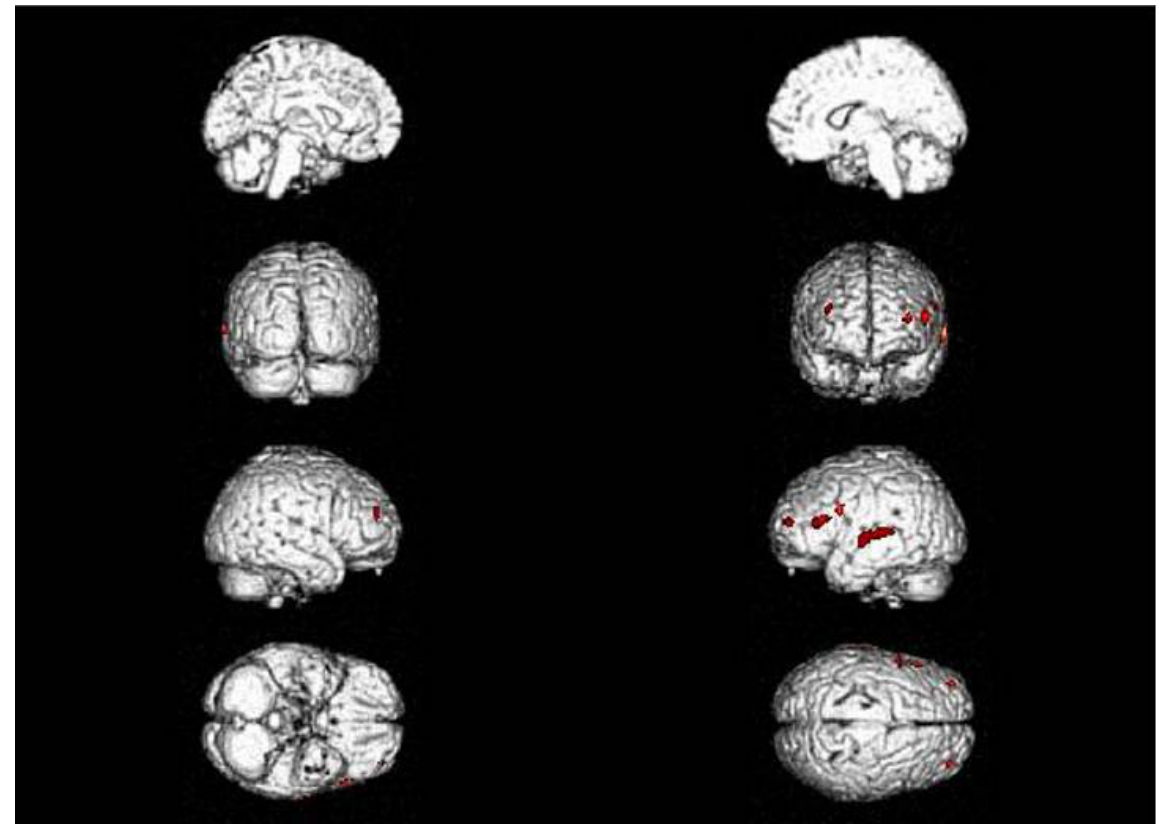
Figure 2. Brain PET with 18F-FDG one year (2013) after symptom onset (early FDG-PET). SPM map of significant hypometabolic areas ( p = 0.0001) in the left inferior frontal gyrus (BA 45), in the prefrontal cortex (BA 9 and BA 10 in the left hemisphere, BA 10 in the right one), and in the left superior temporal gyrus. The results are displayed on the structural MR template included in SPM5. In 2014, the patient passed three neurological assessments, which were still negative.